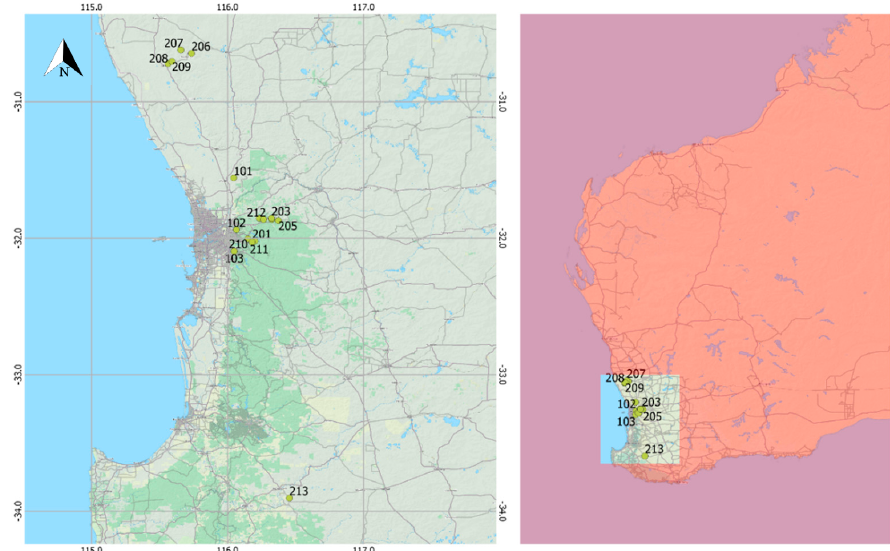
Figure 2. Apiary site locations indicated by yellow markers. Site labels correspond to those listed in Table 1. Coordinates are in World Geodetic System 1984 (WGS84).